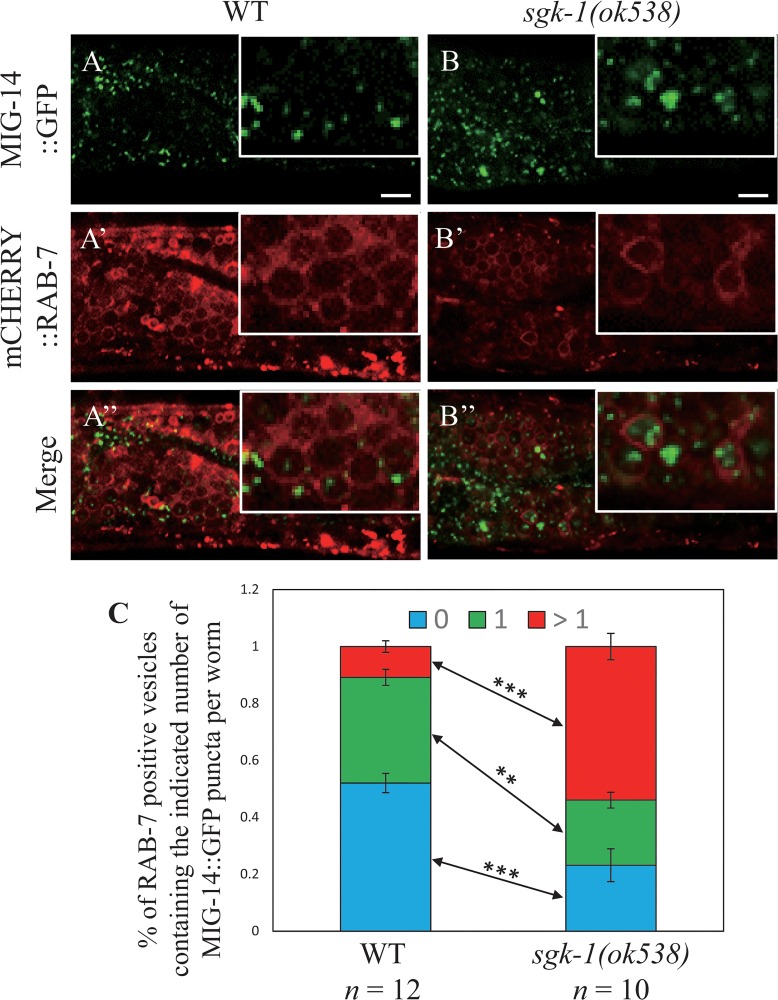
MIG-14::GFP was delivered to early lysosomes marked by RAB-7.Confocal images of the wild type (A, A’, A”) and sgk-1(null) (B, B’, B”) intestinal cells expressing MIG-14::GFP (A, B) or mCHERRY::RAB-7 (A’, B’). Insets show magnified areas (× 2.5). Scale bars: 5 μm. Quantitation of RAB-7-positive ring-like vesicles with or without MIG-14::GFP puncta inside (C). *** P value <0.001, ** P value <0.01 (Student’s t-test).